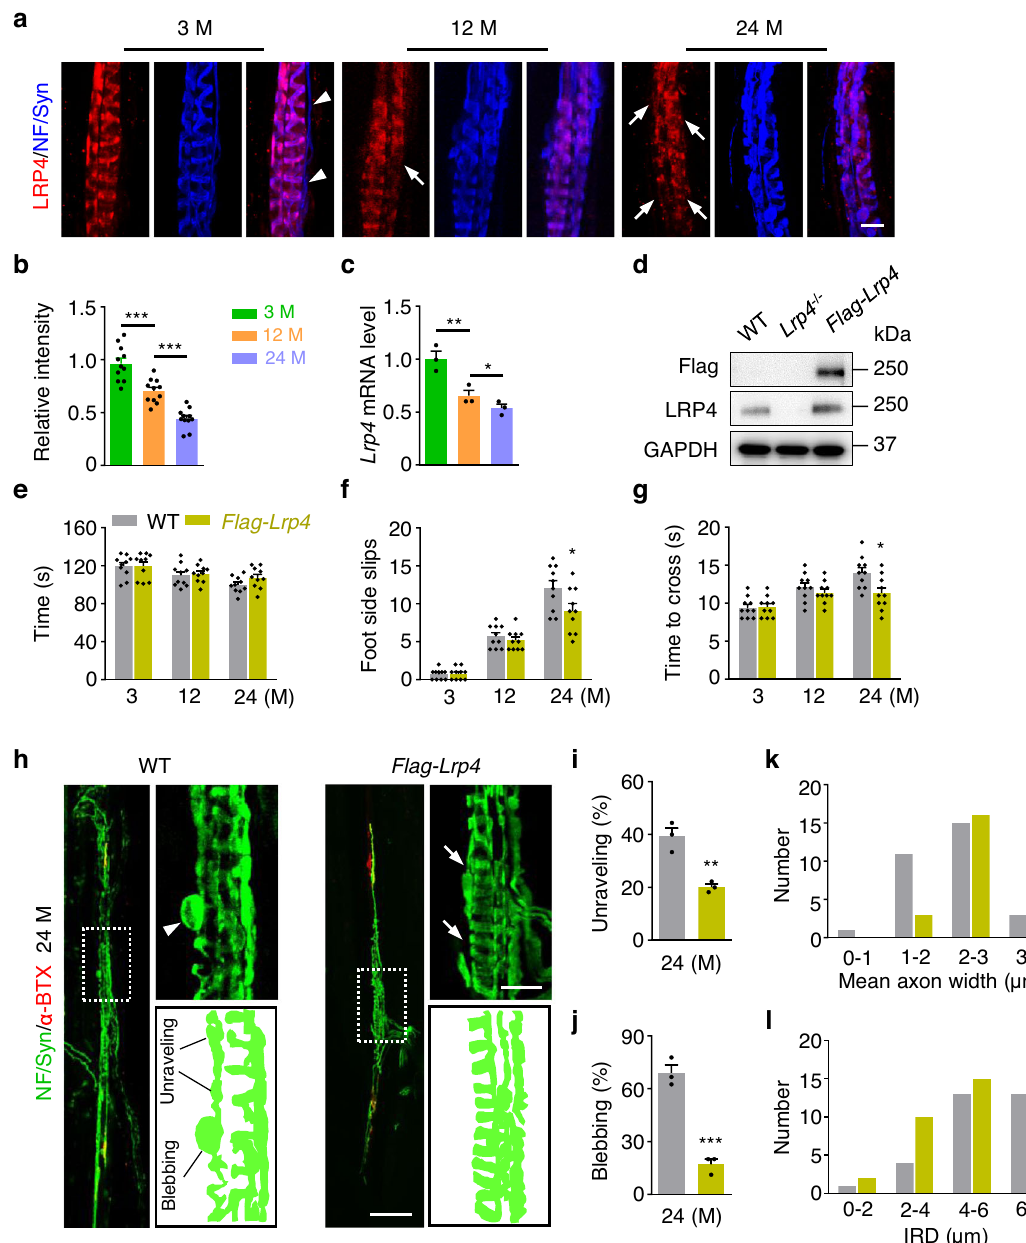
Fig. 8 | Restoring spindle structure and function in aged mice by LRP4 expression. a Representative images of EDL muscles of 3M, 12M, and 24 M-old mice, whole mount stained with 555-anti-LRP4 (red) and NF/Syn (blue). Arrow- heads, non-annulospiral axons had no LRP4 expression. Arrows, LRP4 negative annulospiralendingsinagedmice.Scalebar,10 µ m. b Quanti fi cationoftherelative intensity of LRP4; t (20) = 9.063, *** p <0.0001; t (20) = 4.34, *** p =0.0003. n =11 muscle spindles from 3 mice per group, unpaired two-tailed t test. c Quantitative RT-PCRtestedtherelativeexpressionof Lrp4 mRNAin3M,12Mor24Mmice; t (4) = 5.861,** p =0.004; t (4) =4.006,* p =0.016. n =3micepergroup,unpairedtwo-tailed t test. d Expression of Flag-LRP4 in skeletal muscle was con fi rmed by Western blotting.Uncroppedblotsin Source Data. e Quanti fi cationof longest running time onrotatingrodbetweenWTand Flag-Lrp4 miceatindicatedage. f Quanti fi cationof